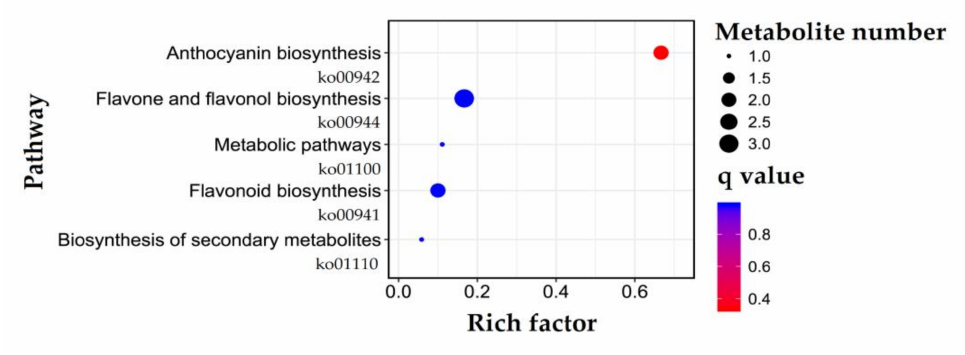
Figure 3. KEGG Orthology (KO) enrichment of the